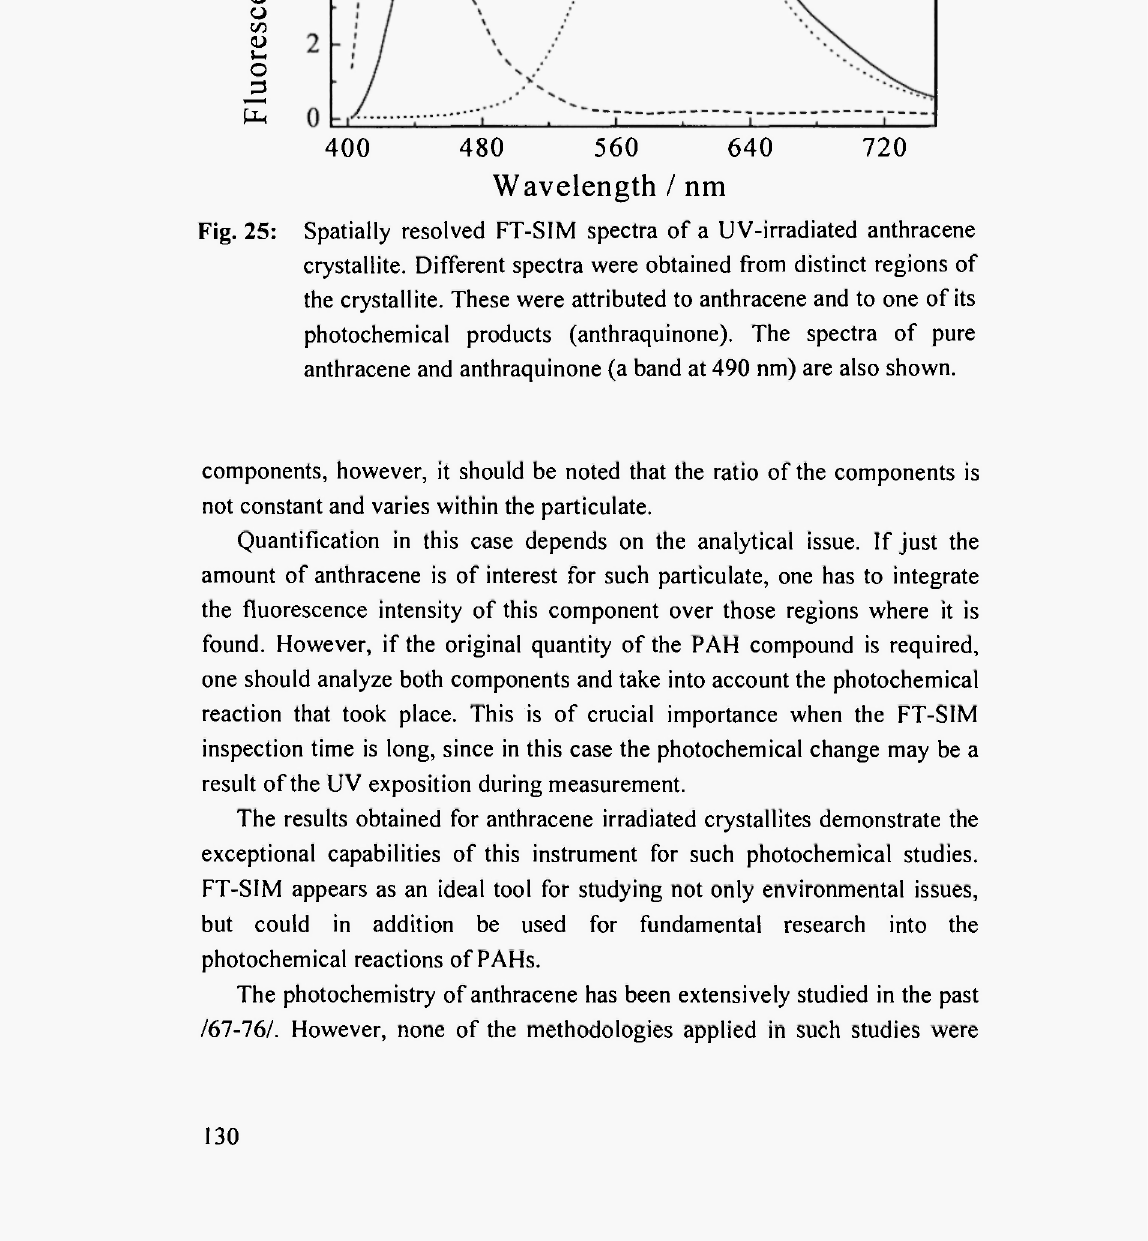
480 560 640 Wavelength / nm Spatially resolved FT-SIM spectra of a UV-irradiated anthracene Fig. 25: crystallite. Different spectra were obtained from distinct regions of the crystallite. These were attributed to anthracene and to one of its photochemical products (anthraquinone). The spectra of pure anthracene and anthraquinone (a band at 490 nm) are also